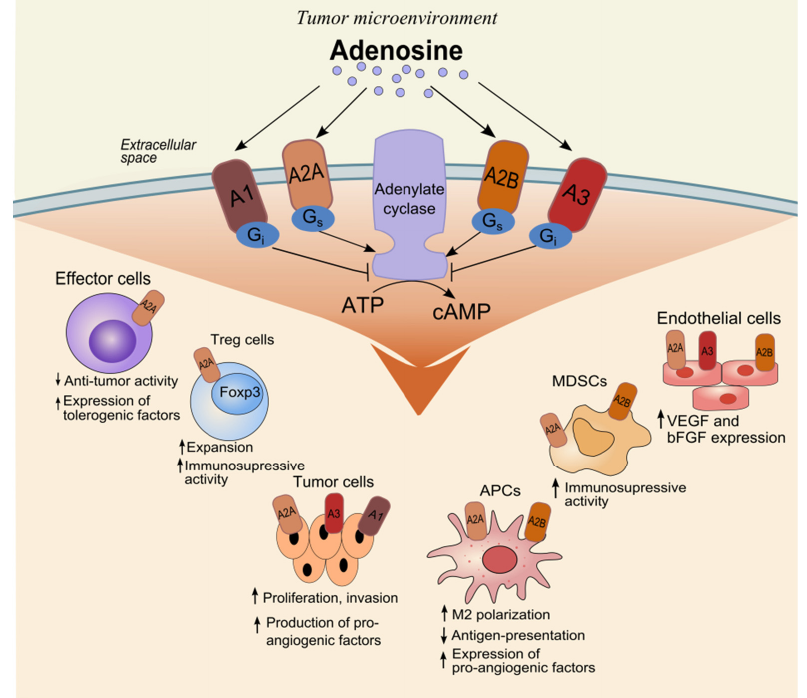
Figure 2. The effect of adenosine on tumor-infiltrating cells. Adenosine can bind to four different G-protein-coupled adenosine receptors that either stimulate (mediated by A2A and A2B adenosine receptors) or inhibit (mediated by A1 and A3 adenosine receptors) adenylate cyclase activity and cAMP production in the cell. Activation of adenosine receptors on various types of cells in the tumor microenvironment can lead to the formation of immunosuppressive conditions and inhibition of the anti-tumor immune response. Abbreviations: ATP: adenosine triphosphate; cAMP: cyclic adenosine monophosphate; Treg: regulatory T cells; Foxp3: forkhead box P3; APCs: antigen-presenting cells; MDSCs: myeloid-derived suppressor cells; VEGF: vascular endothelial growth factor; bFGF: basic fibroblast growth factor.